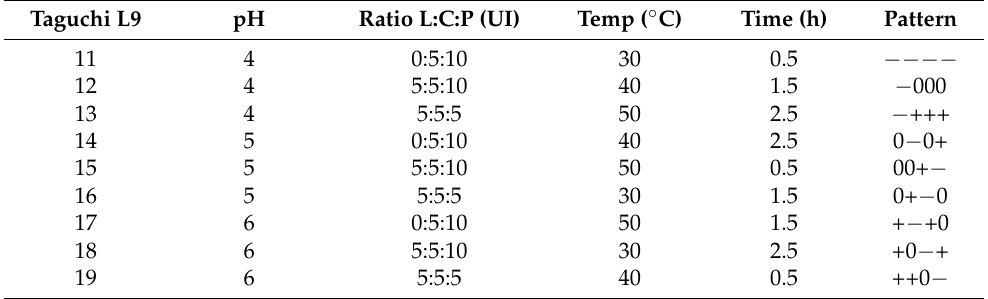
Table A2. Randomly generated Taguchi L9 orthogonal array for the experiment design with four variables and three factors: pH, the proportion of laccase, cellulase, and pectinase in the mix, temperature, and incubation time.